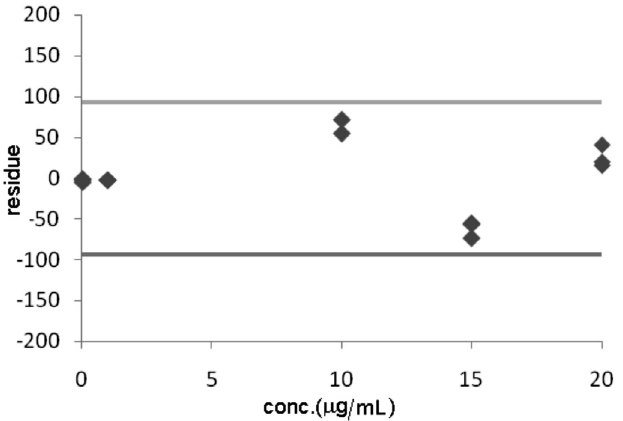
FIGURE 4 - Residual plots for outlier treatment by Jacknife standardized residuals test, demonstrating maximum and minimum allowed intervals. The horizontal lines correspond to ± (t ) s . 0.975; n-2 res